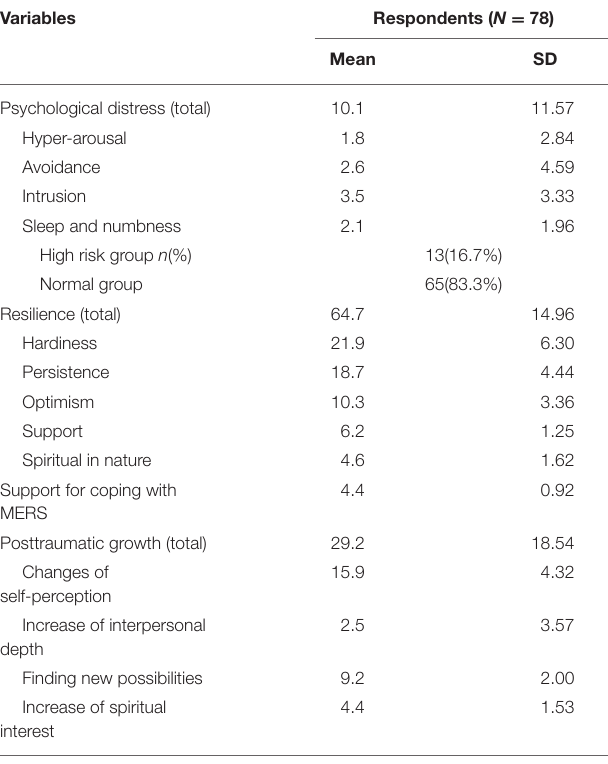
TABLE 3 | Psychological distress, resilience, and support for coping with MERS and posttraumatic growth of participants. Variables